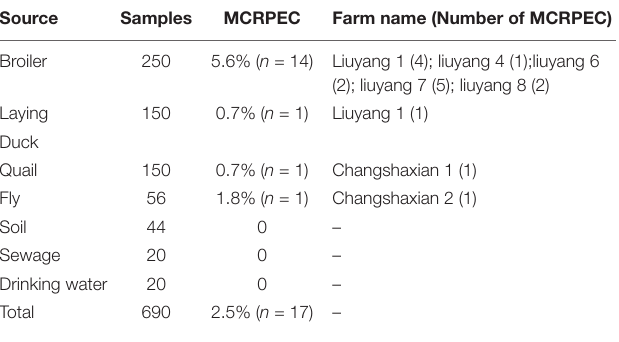
TABLE 1 | Isolation rate of mcr -positive Escherichia coli (MCRPEC) from different